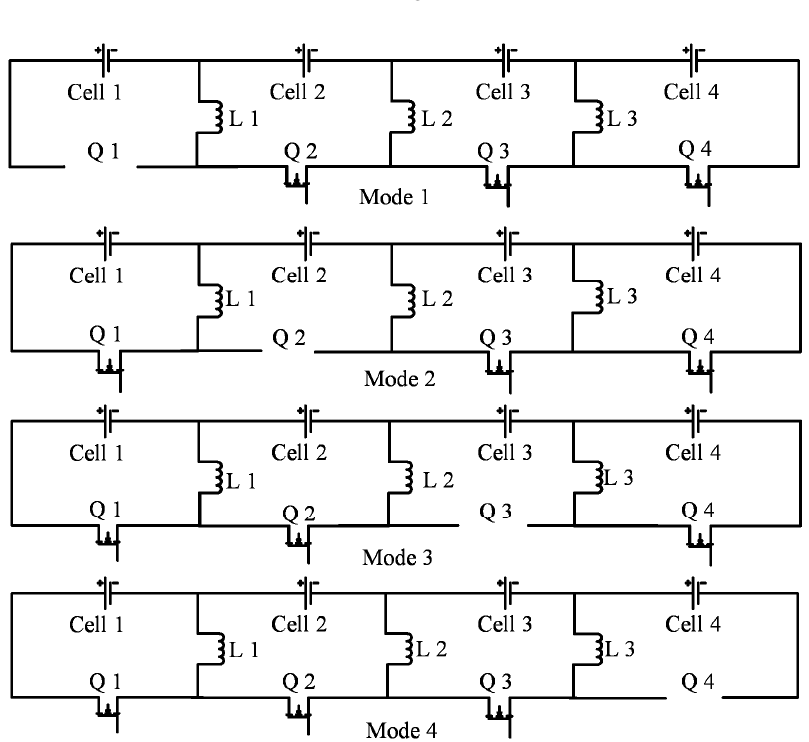
Figure 2. Control signals of MOSFET. Energies 2017 , 10 , 1034